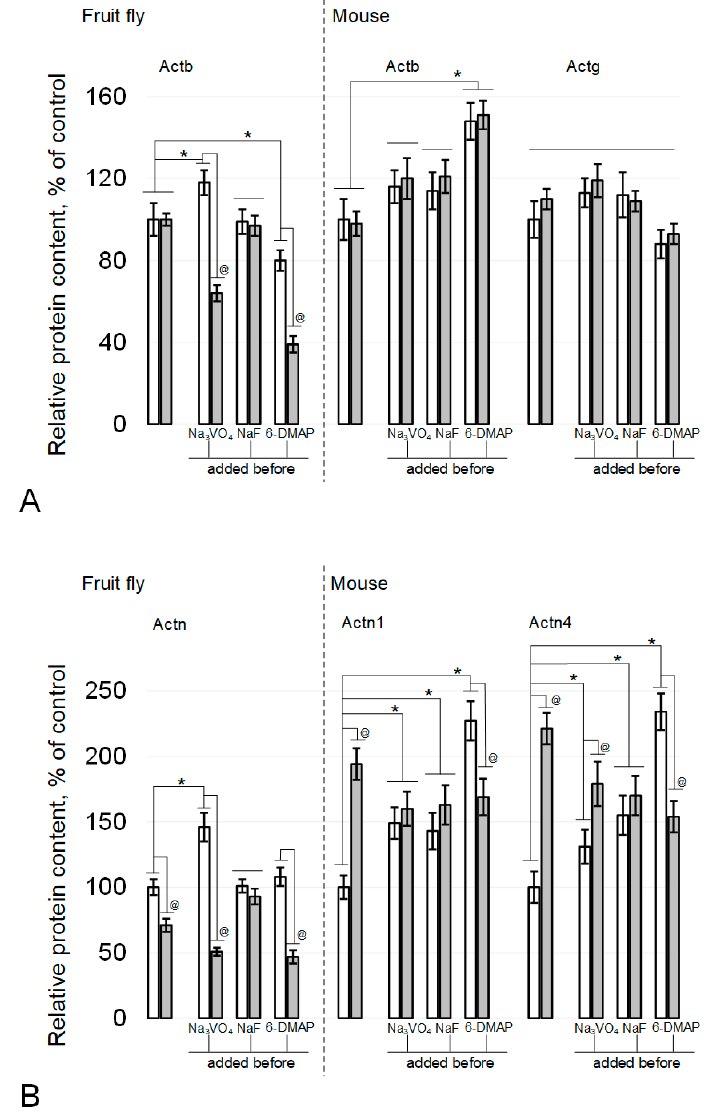
Figure 4. Actin and alpha-actinin isoforms relative content in the fly and mouse sperm. ( A ) actin isoforms, beta-actin Actb and gamma-actin Actg. ( B ) alpha-actinin isoforms, alpha-actinin Actn ( Drosophila melanogaster ), alpha-actinin1 Actn1 (mouse) and alpha-actinin4 Actn4 (mouse). White columns—control, grey columns—after 6 h exposure under modelling microgravity conditions. @ p < 0.05 in comparison with according control group, * p < 0.05 in comparison with control